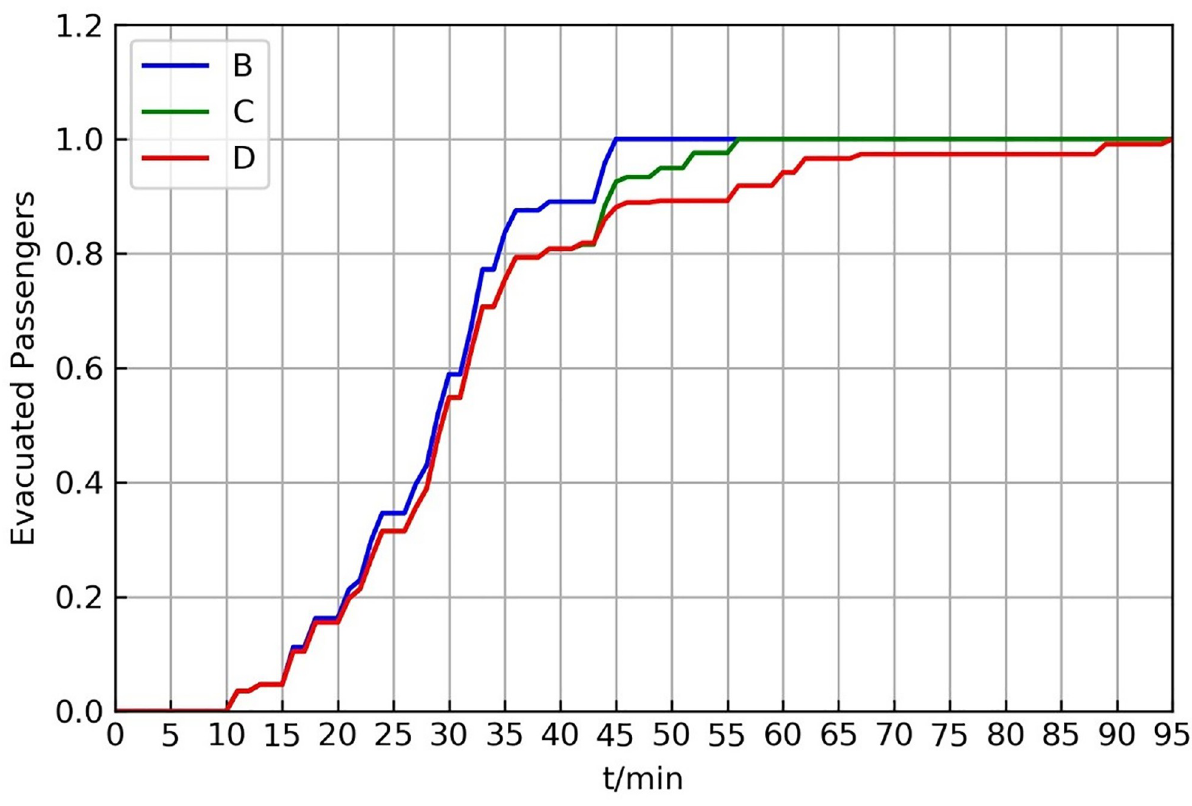
Fig 6. Optimal schemes for different resource